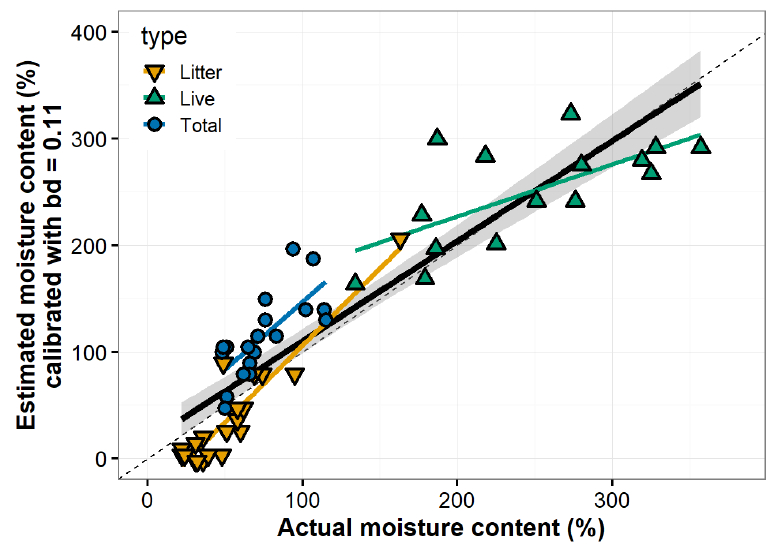
Figure 3. An adjusted bulk density parameter (0.11 g/cm 3 ) improved fit between estimated and actual WC; coefficients in Equation (3) reflect this adjustment. The original calibration equation in which Equation (2) coefficients were divided by mean bulk density (0.072 g/cm 3 ) substantially overpredicted WC (Figure A2). Dotted line shows the 1:1 relationship at which variables would be perfectly